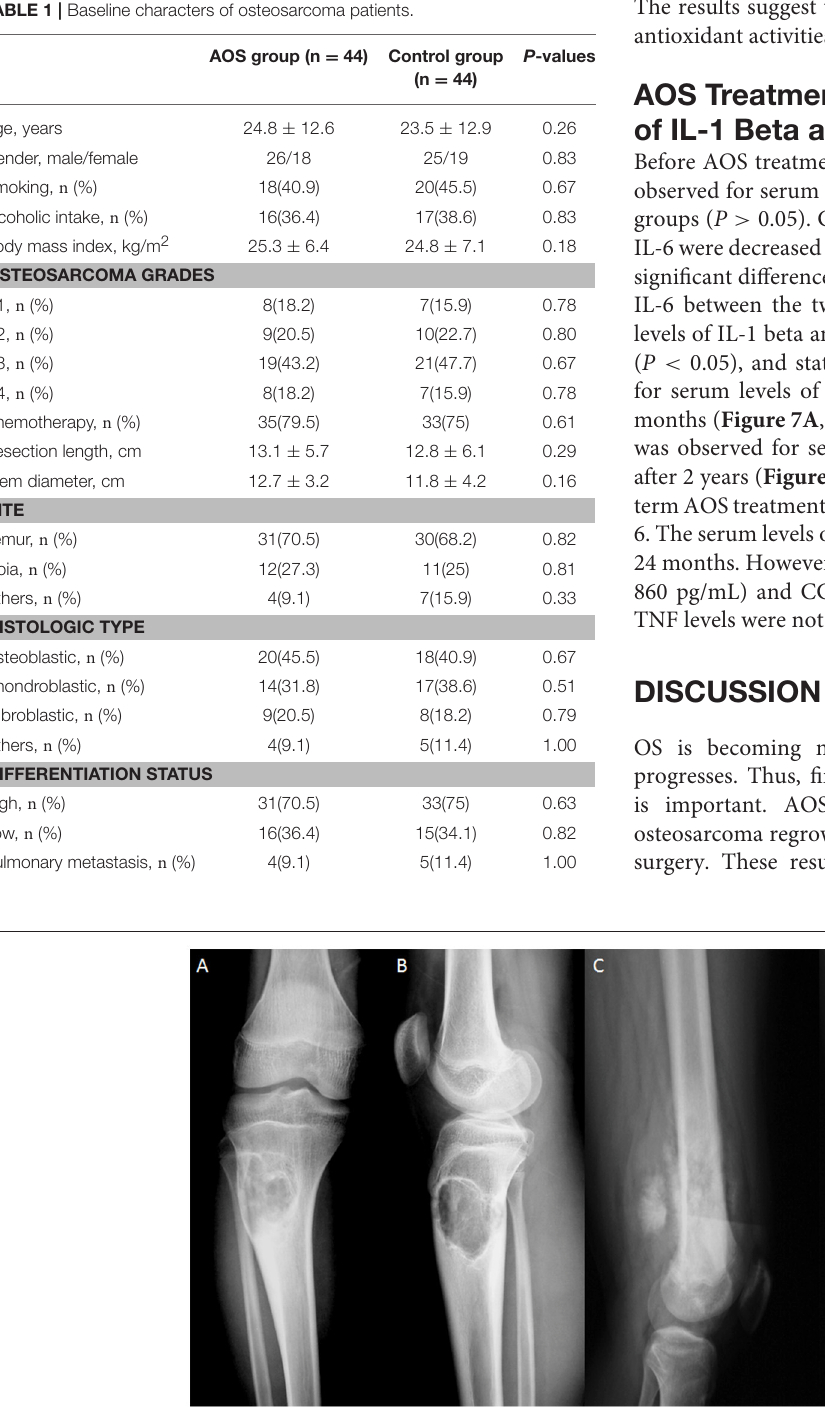
FIGURE 4 | MRI images of OS at different stages. (A) OS at G1 grade. (B) OS at G2 grade. (C) OS at G3 grade. (D) OS at G4